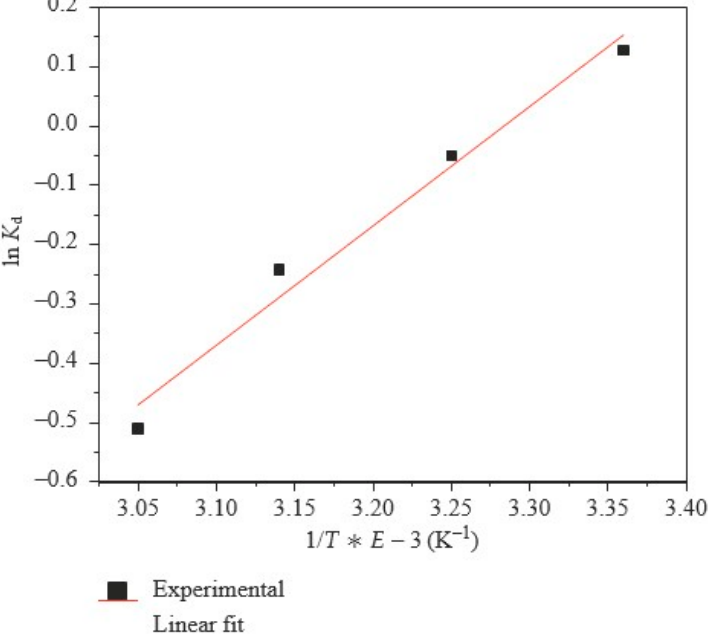
Figure 17. Van ’t Hoff graph for the sorption of malachite green on thiourea-modified-poly(AN co-AA) (malachite green: 100 ppm; adsorbent dose: 500 mg; contact time: 60 min; agitation speed: 100 rpm) Adapted with the permission from the reference [62].